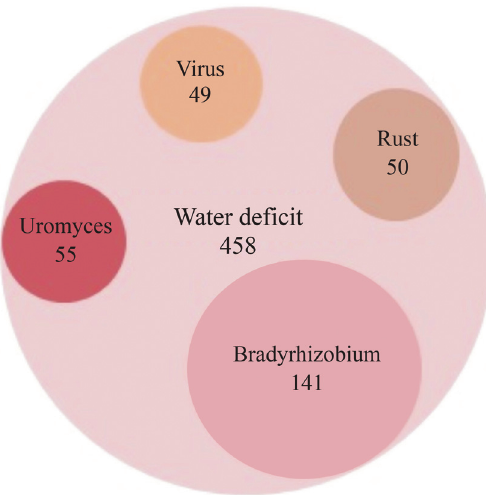
Figure 6 - Multiple stress genes. Genes identified in drought-stressed plants were compared to transcripts expressed when soybean plants were infected by Phakopsora pachyrhizi, Uromyces appendiculatus , virus and treated with Bradirhyzobium japonicum. Contig sequences were aligned and sequences common among experiments are